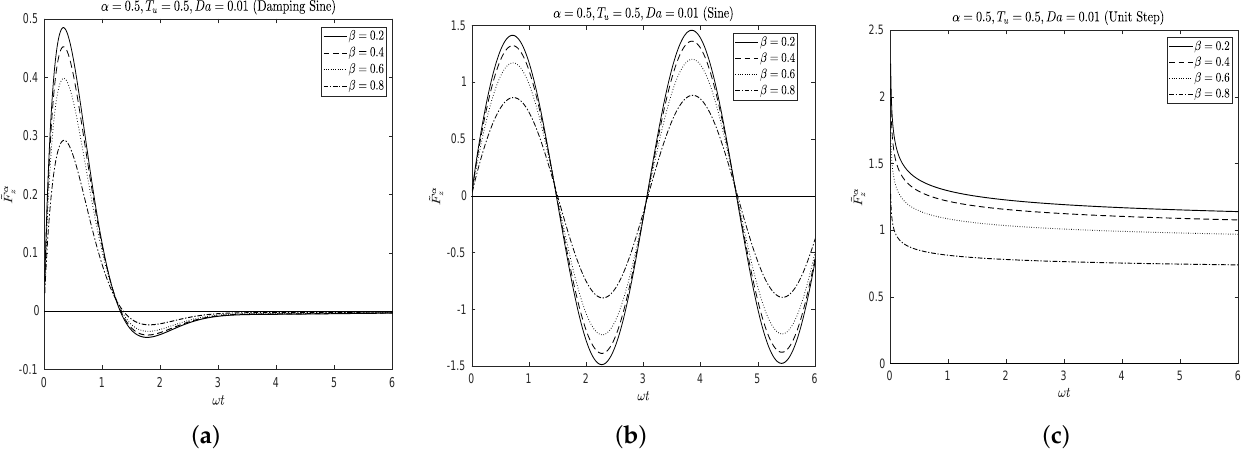
Figure 4. Variation of drag force at different β for all three cases: ( a ) damping sine oscillation, ( b ) sine oscillation, ( c ) Unit step function.